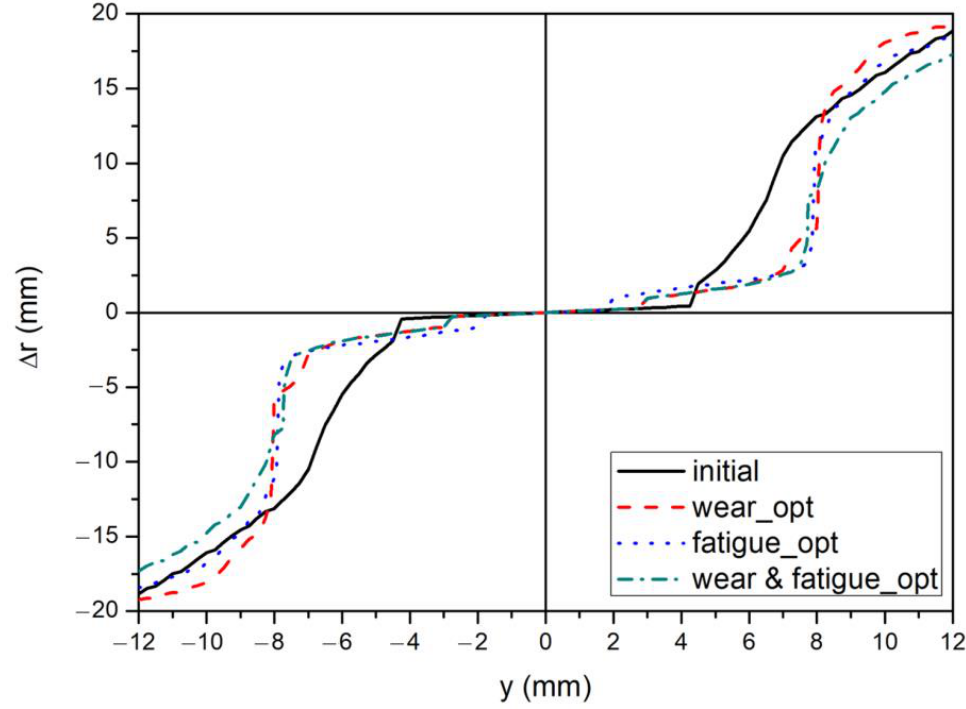
Figure 7. Comparison of RRD.